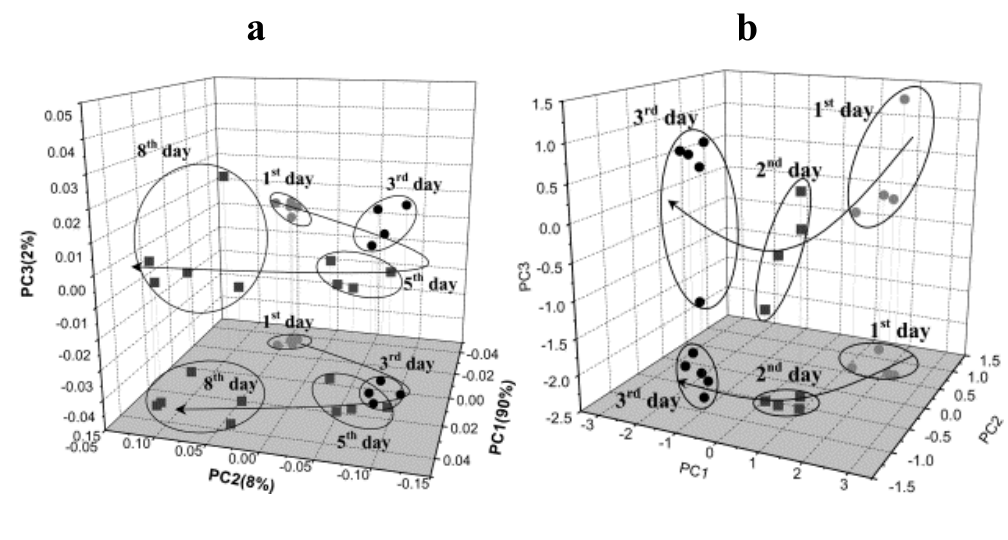
Figure 2. PCA plot based on E-nose measurements of (a) UHT milk and (b) pasteurized milk showing ageing of milk over 8 and 3 days respectively (reprinted from [37] with permission from Elsevier, copyright